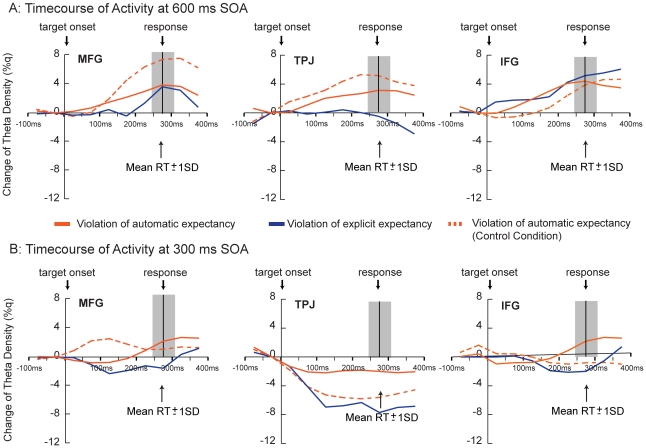
The time course of the change in theta density for 600 ms SOA (3A) and for 300 ms SOA(3B).The data show percent change in theta density (%q) for each 50 ms time interval relative to 50 ms pre-target baseline for MFG [x = 45, y = 6, z = 46], TPJ [x = 52, y = −50, z = 28], and IFG [x = 48, y = 14, z = 10] ROIs for the experimental and control conditions as a function of target congruency. The data reflect the percent theta change computed for each 50 ms time bin across the entire trial period (including the cue activity, target activity, and 100 ms of post target activity) relative to 50 ms pre-cue baseline. Then, for each time bin, these theta density values were normalized to the 50 ms pre-target activity. The shaded area depicts ±1SD of the overall mean of the response in the experimental condition (278 ms). Please note that the time resolution of the MSBF analysis is limited to 50 ms.